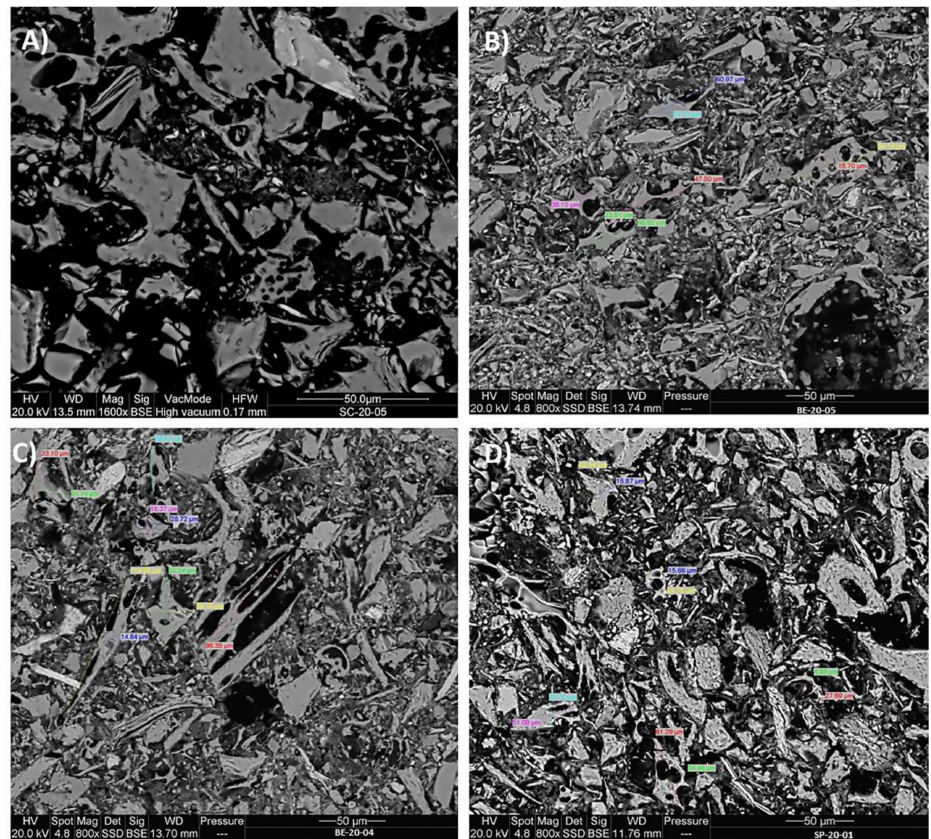
Figure 8. Micro-texture of volcanic glass fragments under SEM. ( A ) Shards and micro-pumices. ( B ) fine-grained volcaniclastic bed of BE outcrop (BE-20-05). ( C ) Coarse-grained volcaniclastic bed of BE outcrop (BE-20-04). ( D ) SP volcaniclastic bed (SP-20-01).